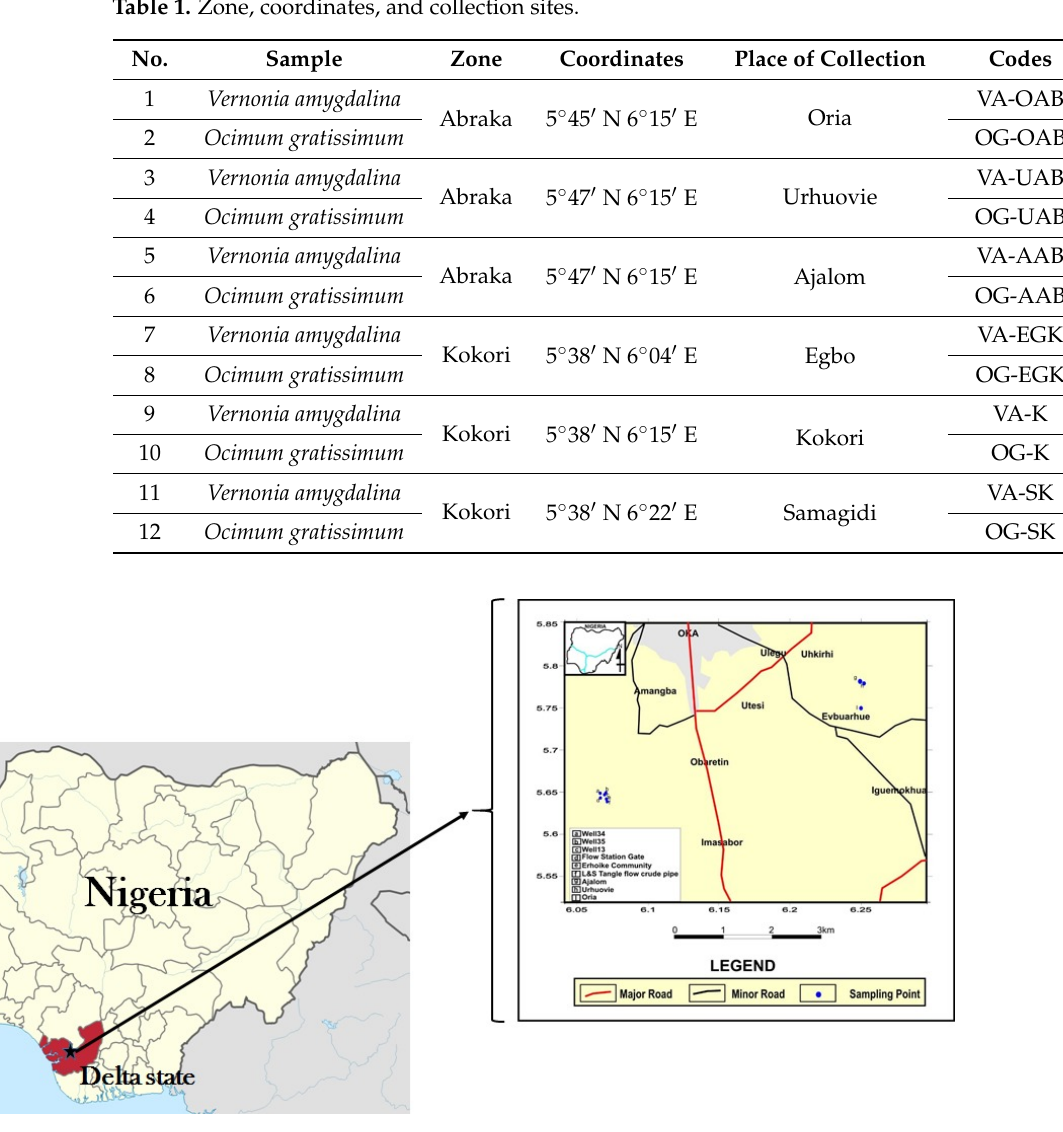
Figure 1. Map showing study area and collection sites in Delta State. Map of the study area has been adapted from Ozabor and Obaro, 2016 [12] while the Nigerian map was adapted from https://en.wikipedia.org/wiki/Delta State and www.deltastate.gov.ng (accessed on 21 September 2021).